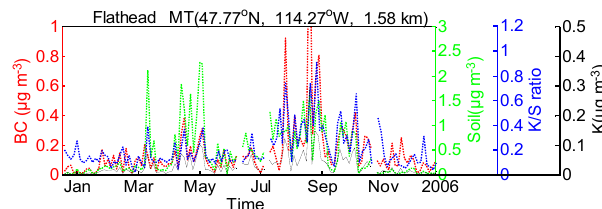
Fig. 5. Daily surface concentrations of BC (red line), soil (green Figure 5. Daily surface concentrations of BC (red line), soil (green line), potassium (K, line), potassium (K, black line), and potassium to sulfur (K/S) ra- black line), and potassium to sulfur (K/S) ratio (blue line) at IMPROVE site Flathead, MT tio (blue line) at IMPROVE site Flathead, MT (47.8 ◦ N, 114.3 ◦ W, (47.8°N, 114.3°W, 1.58 km) for 2006. 1.58km) for